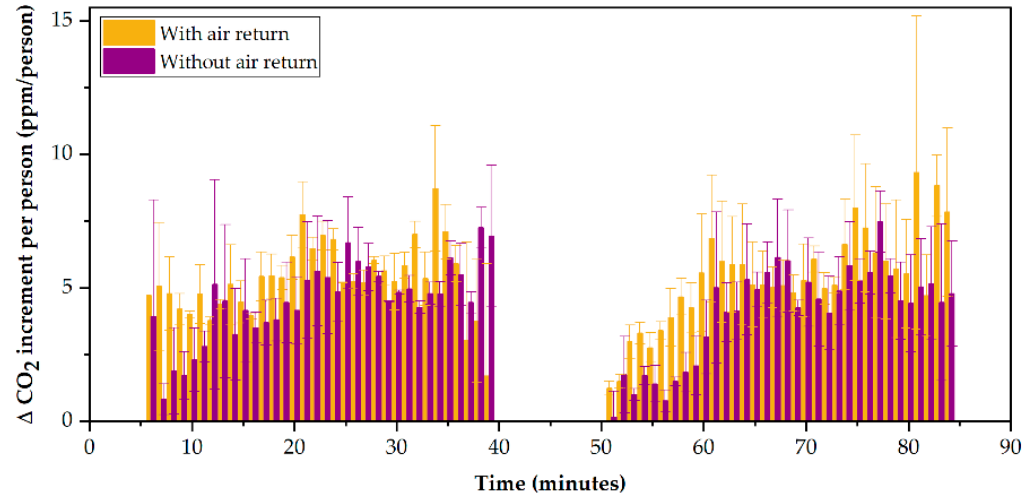
Figure 7. Registered ppm/person values depending on the air return.